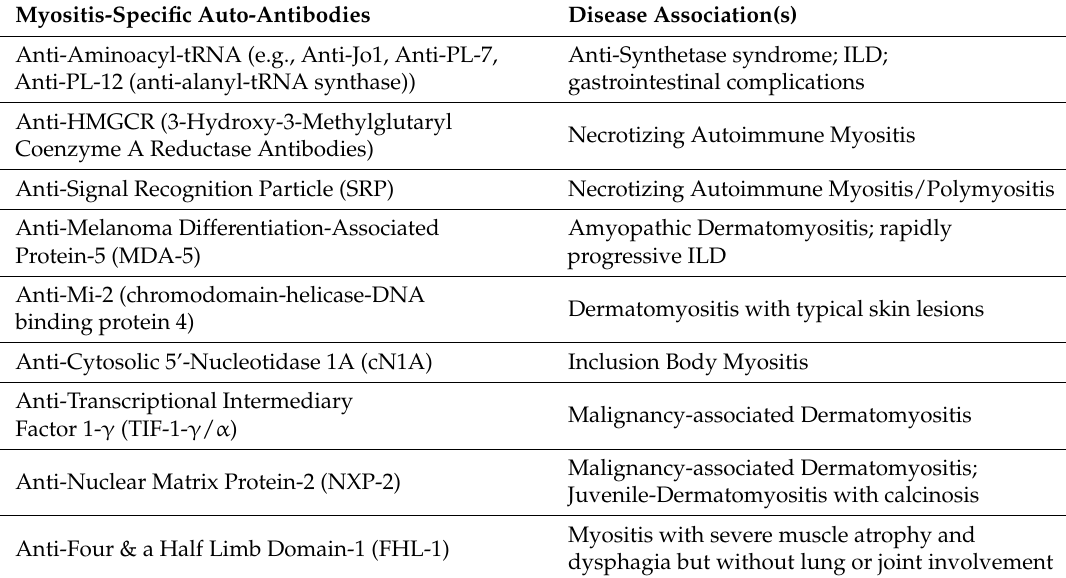
Table 2. Myositis specific antibodies and disease associations [2,4,8]. The specificity of autoantibodies on the associated disease processes is unknown as is their role in the pathogenicity of